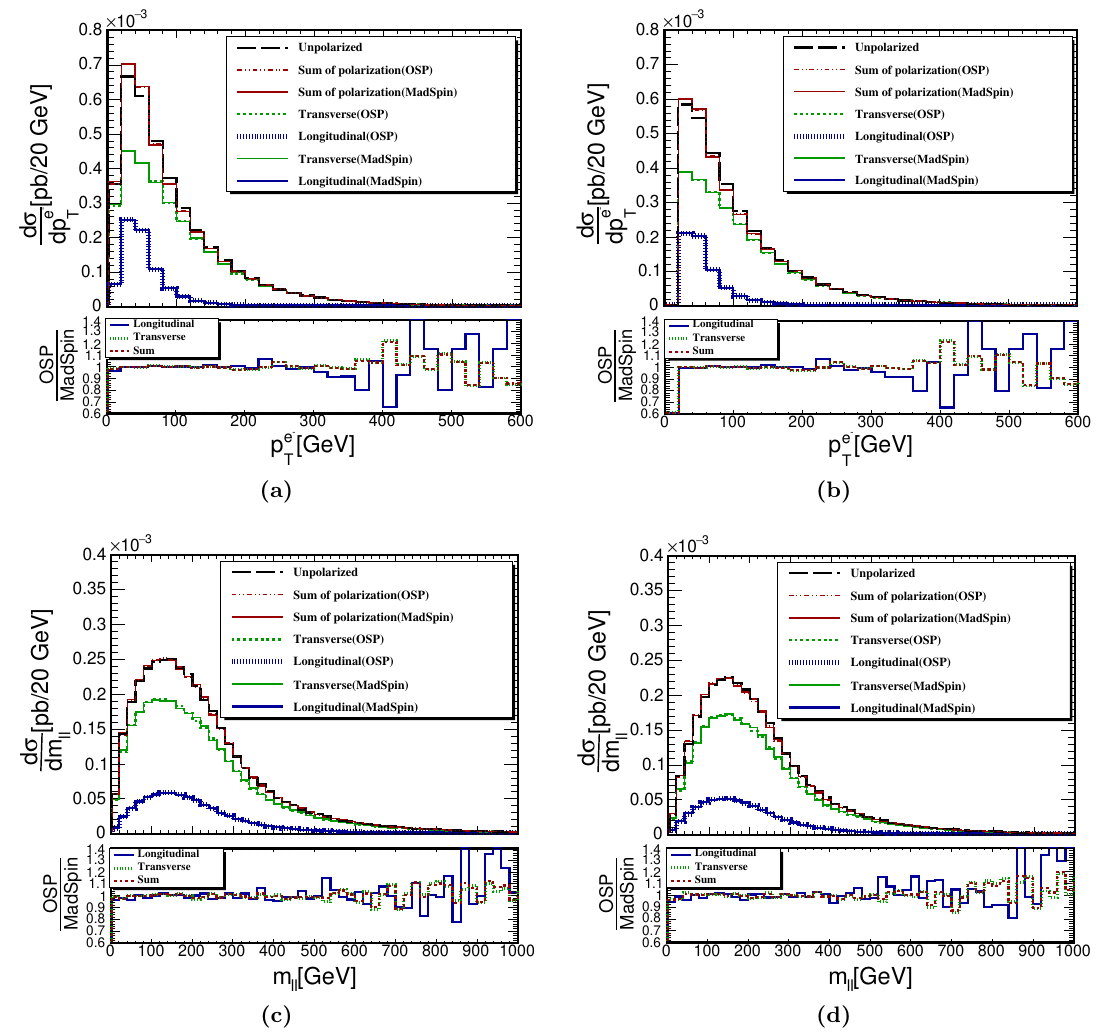
Figure 4. Same as (cid:12)gure 2 but for (a,b) p T ( e (cid:0) ) and (c,d) M ( (cid:22) + e (cid:0) ), assuming (a,c) only generator- level cuts of eq. (4.15) and (b,d) both eq. (4.15) and analysis-level cuts of eq.